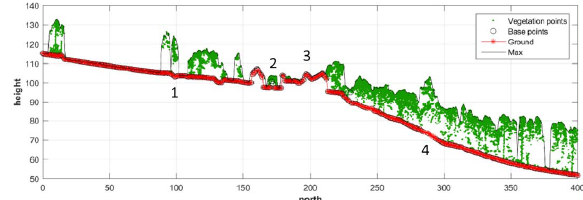
Figure 6: Vegetation filter on a typical terrain, showing the results for a cross